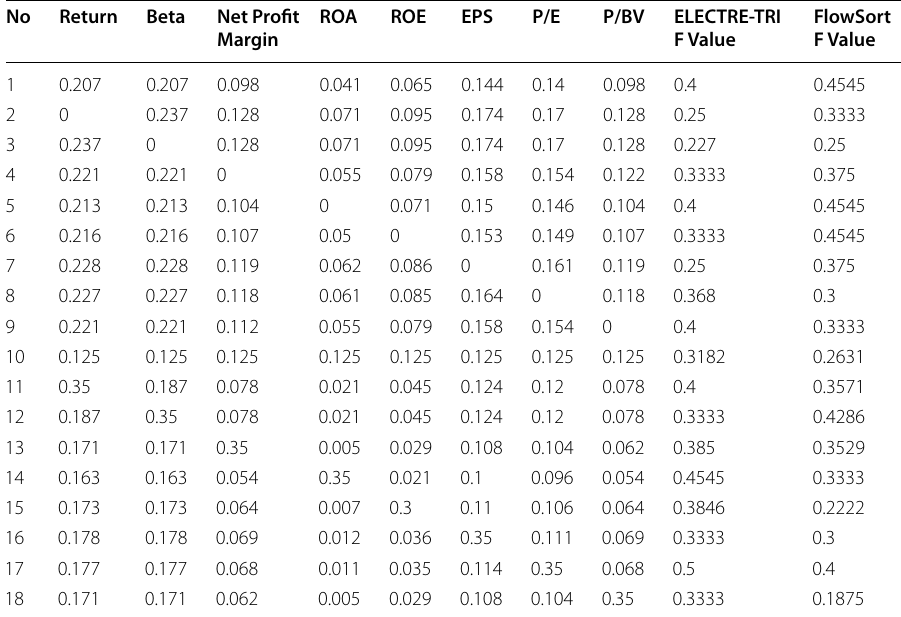
Table 10 Sensitivity analysis on the weight of criteria No